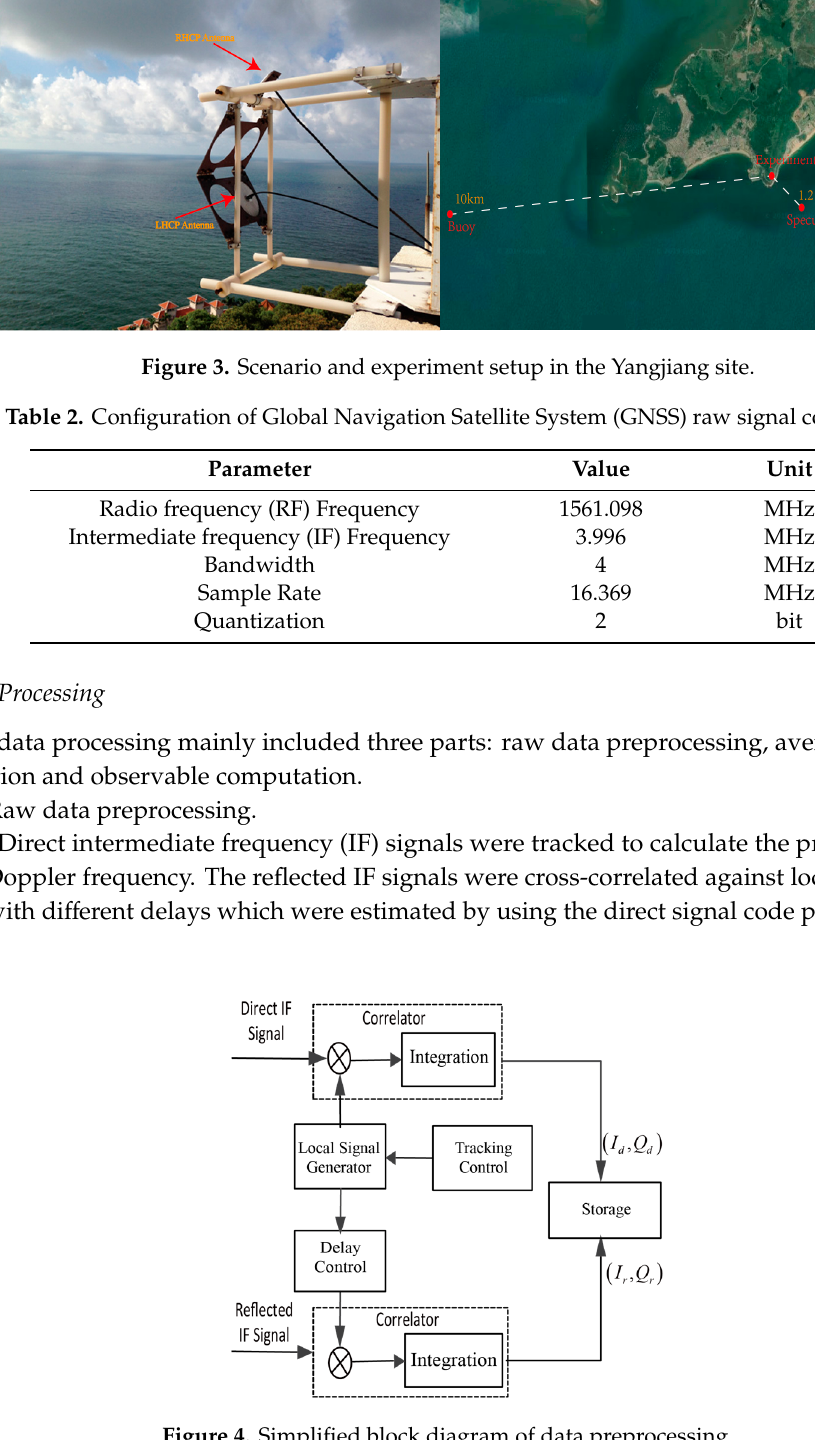
Figure 4. Simplified block diagram of data preprocessing.